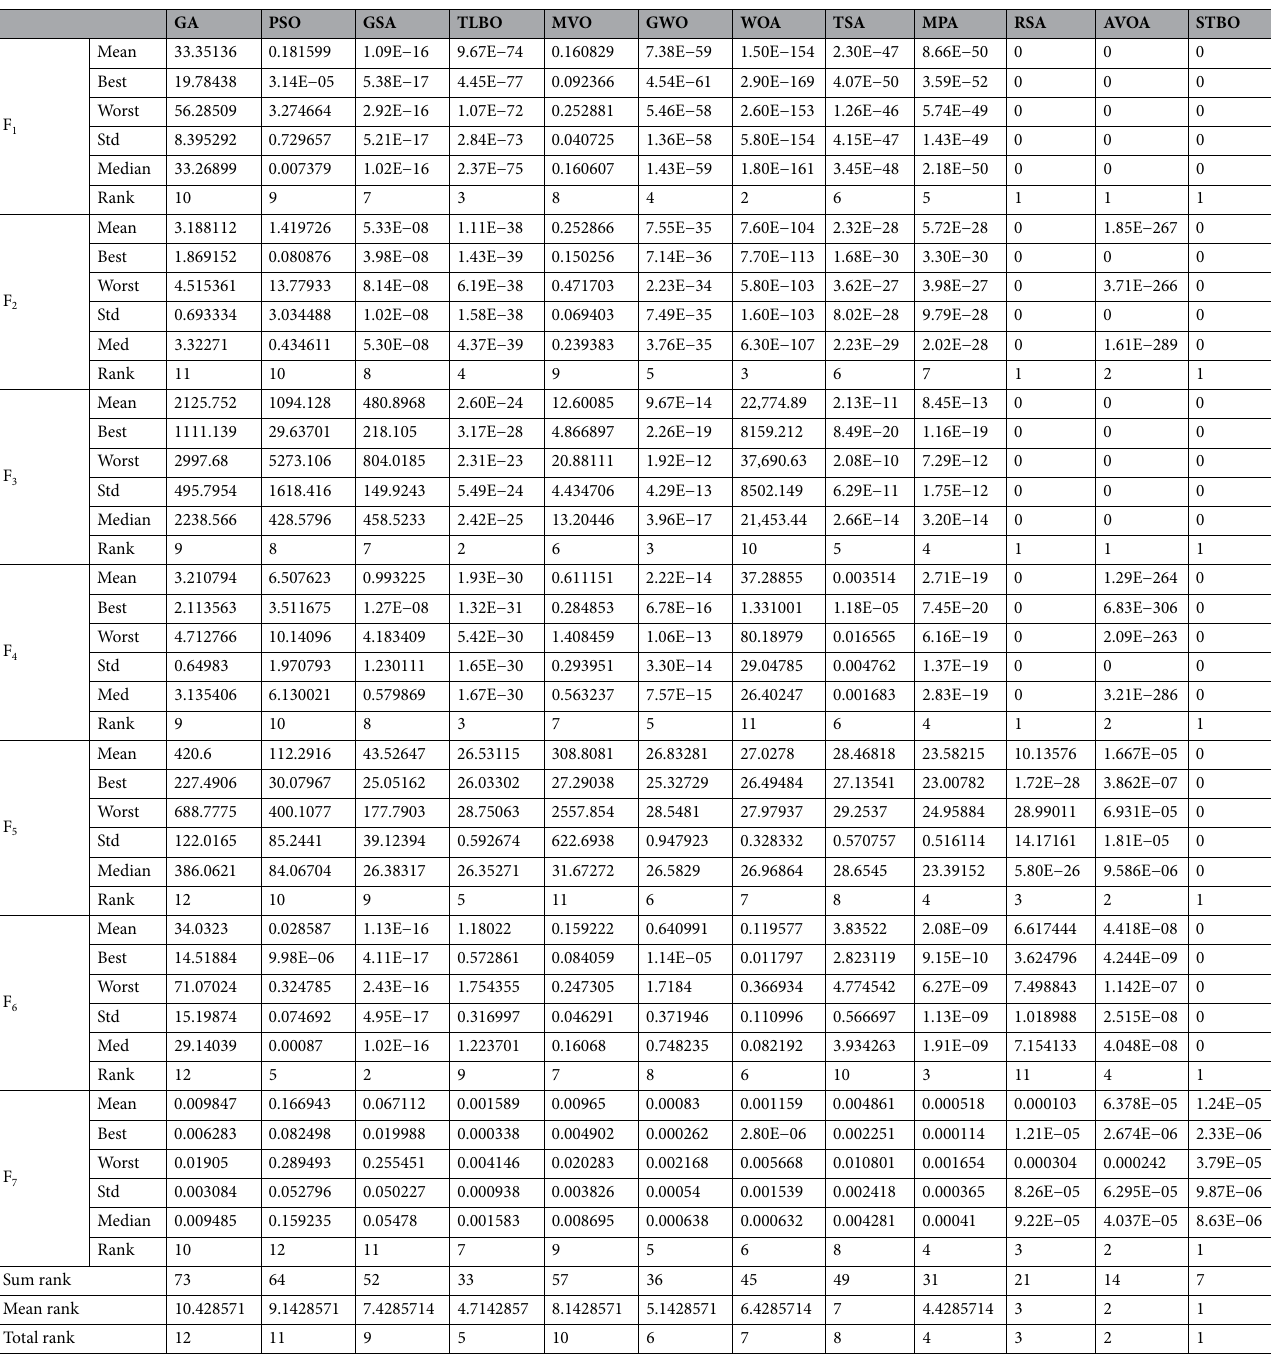
Table 3. Evaluation results on unimodal